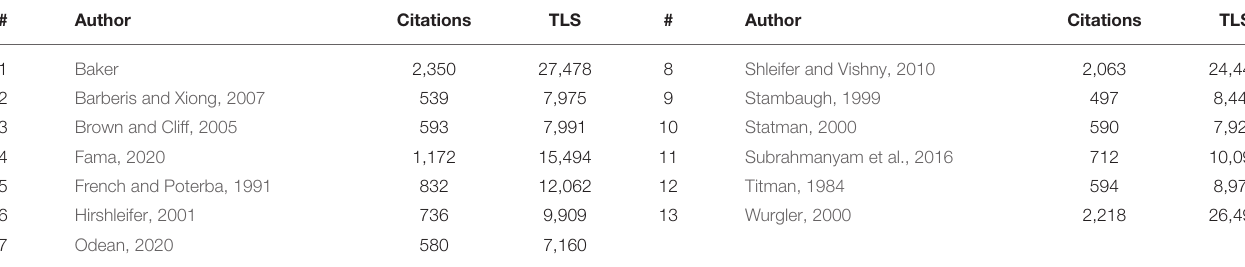
TABLE 2 | Key authors based on citations and TLS (total link strength).